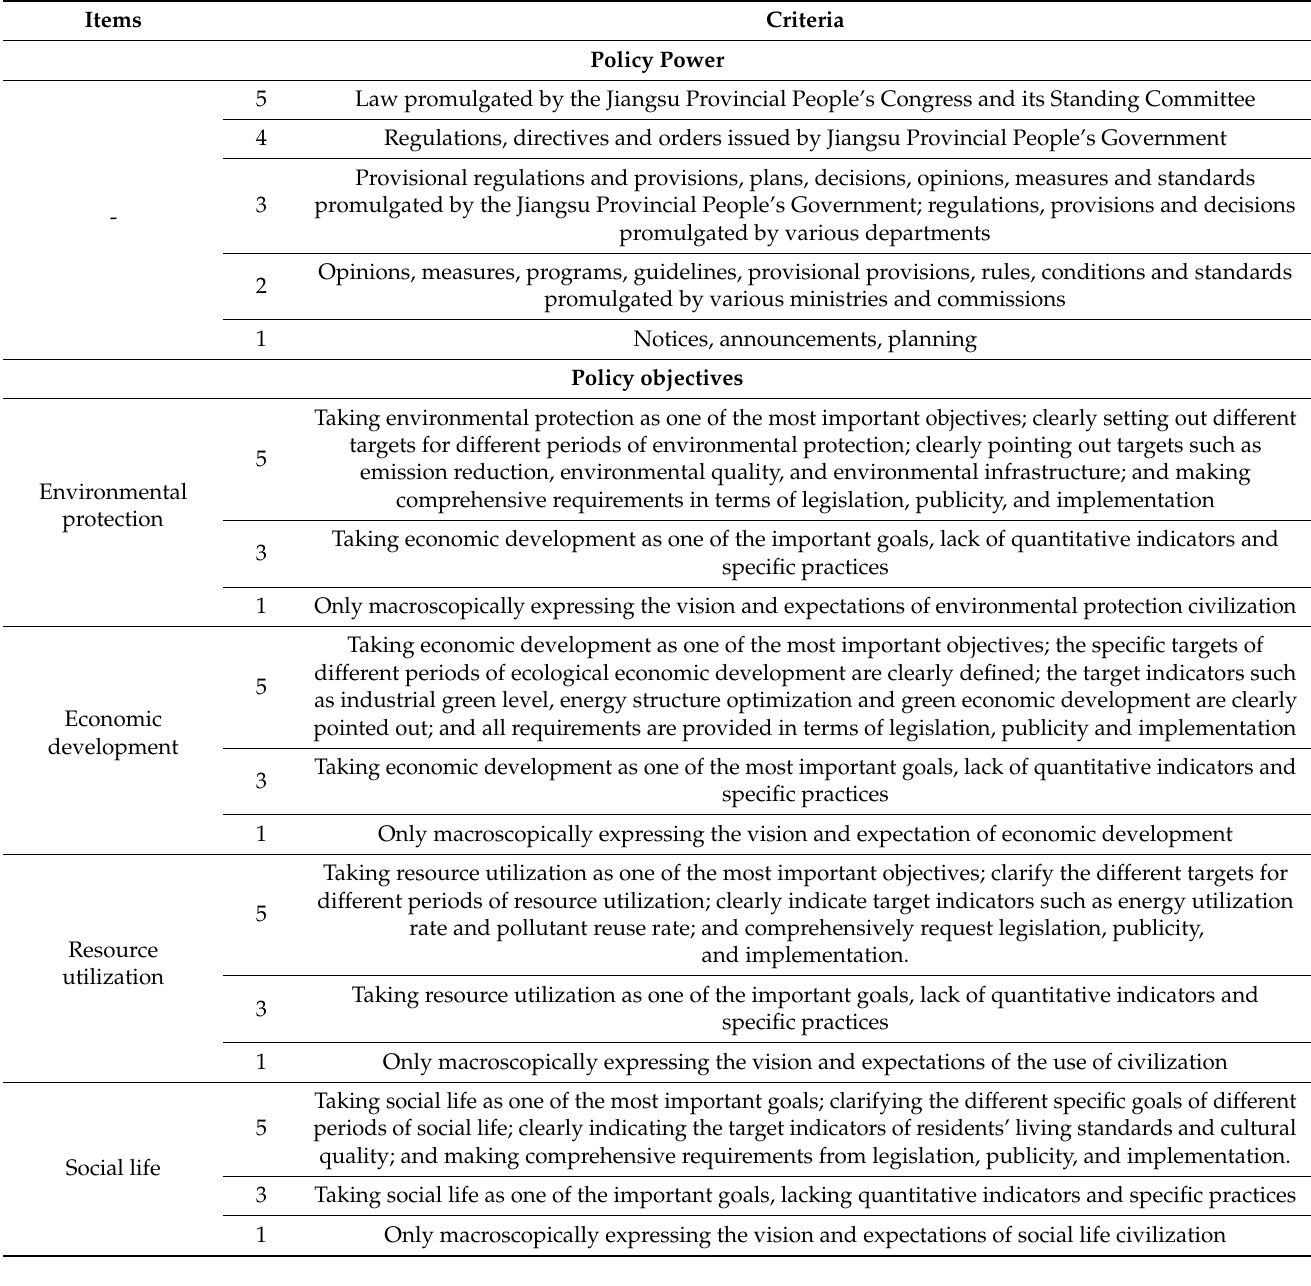
Table A1. Policy Quantification